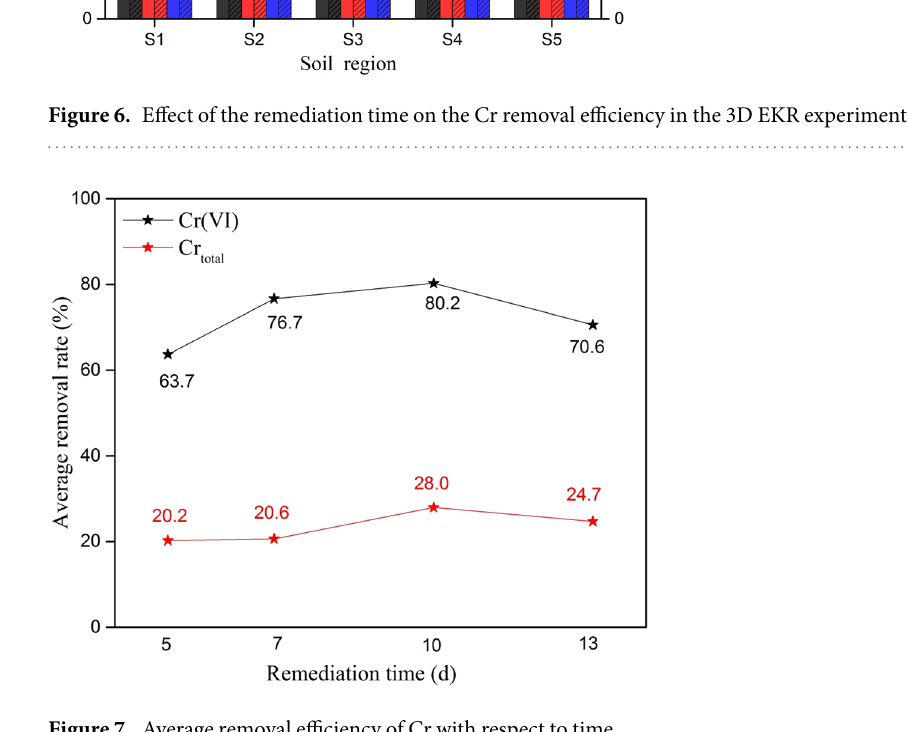
Figure 7. Average removal efficiency of Cr with respect to